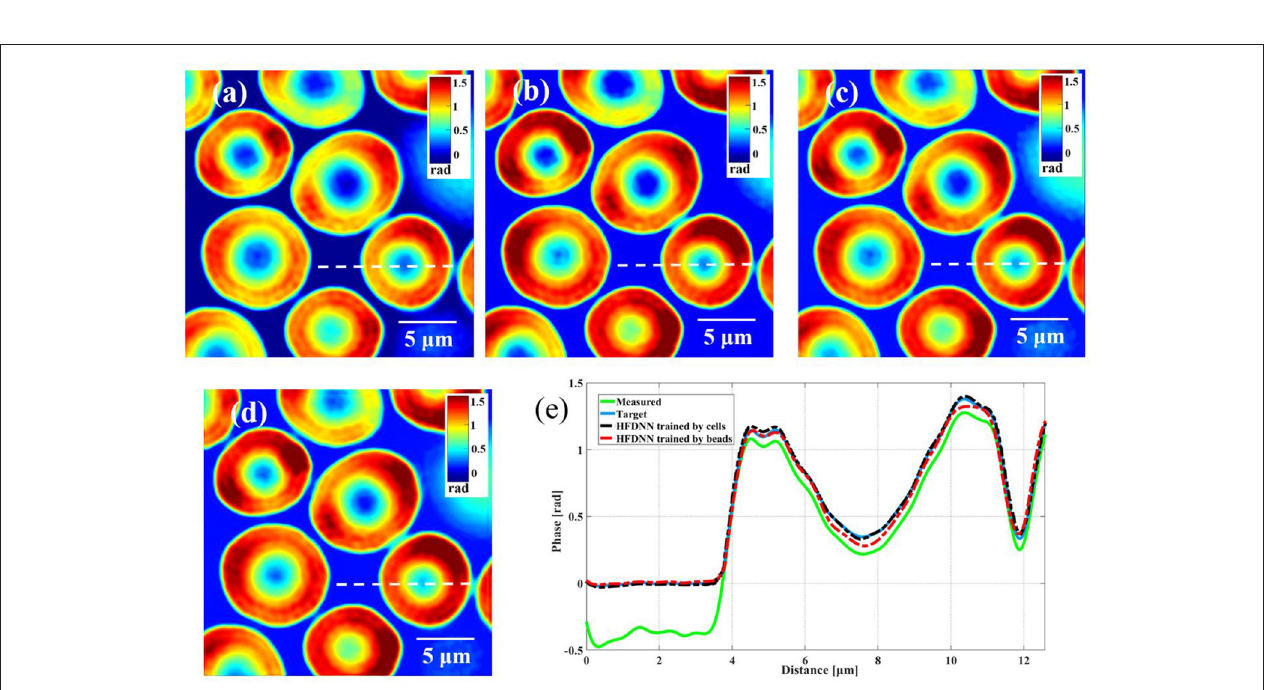
FIGURE 6 | The comparison of the reconstructed results of living red blood cells. (a) The measured image; (b) the target data by the iteration method; (c) the reconstructed image by the HFDNN trained by red blood cells; (d) the reconstructed image by the HFDNN trained by beads; (e) the phase profiles along the same position of the same cell drawn in (a–d) ; the green curve illustrates the profile of the measured data; the blue curve illustrates the profile of the target data; the black dash curve illustrates the profile of the HFDNN trained by cells; the red dash curve illustrates the profile of the HFDNN trained by beads.